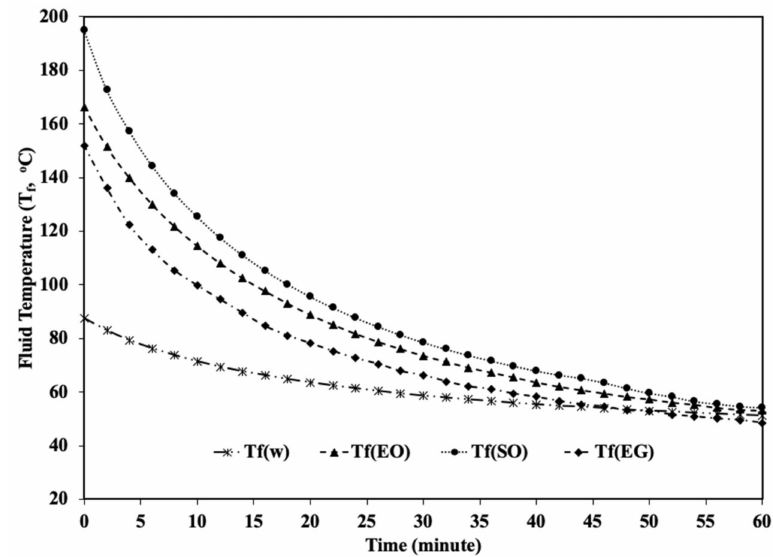
Figure 7. Cooling curves of HTFs (EO 15 November, EG 17 November, SO 20 November and water 23 November 2021).